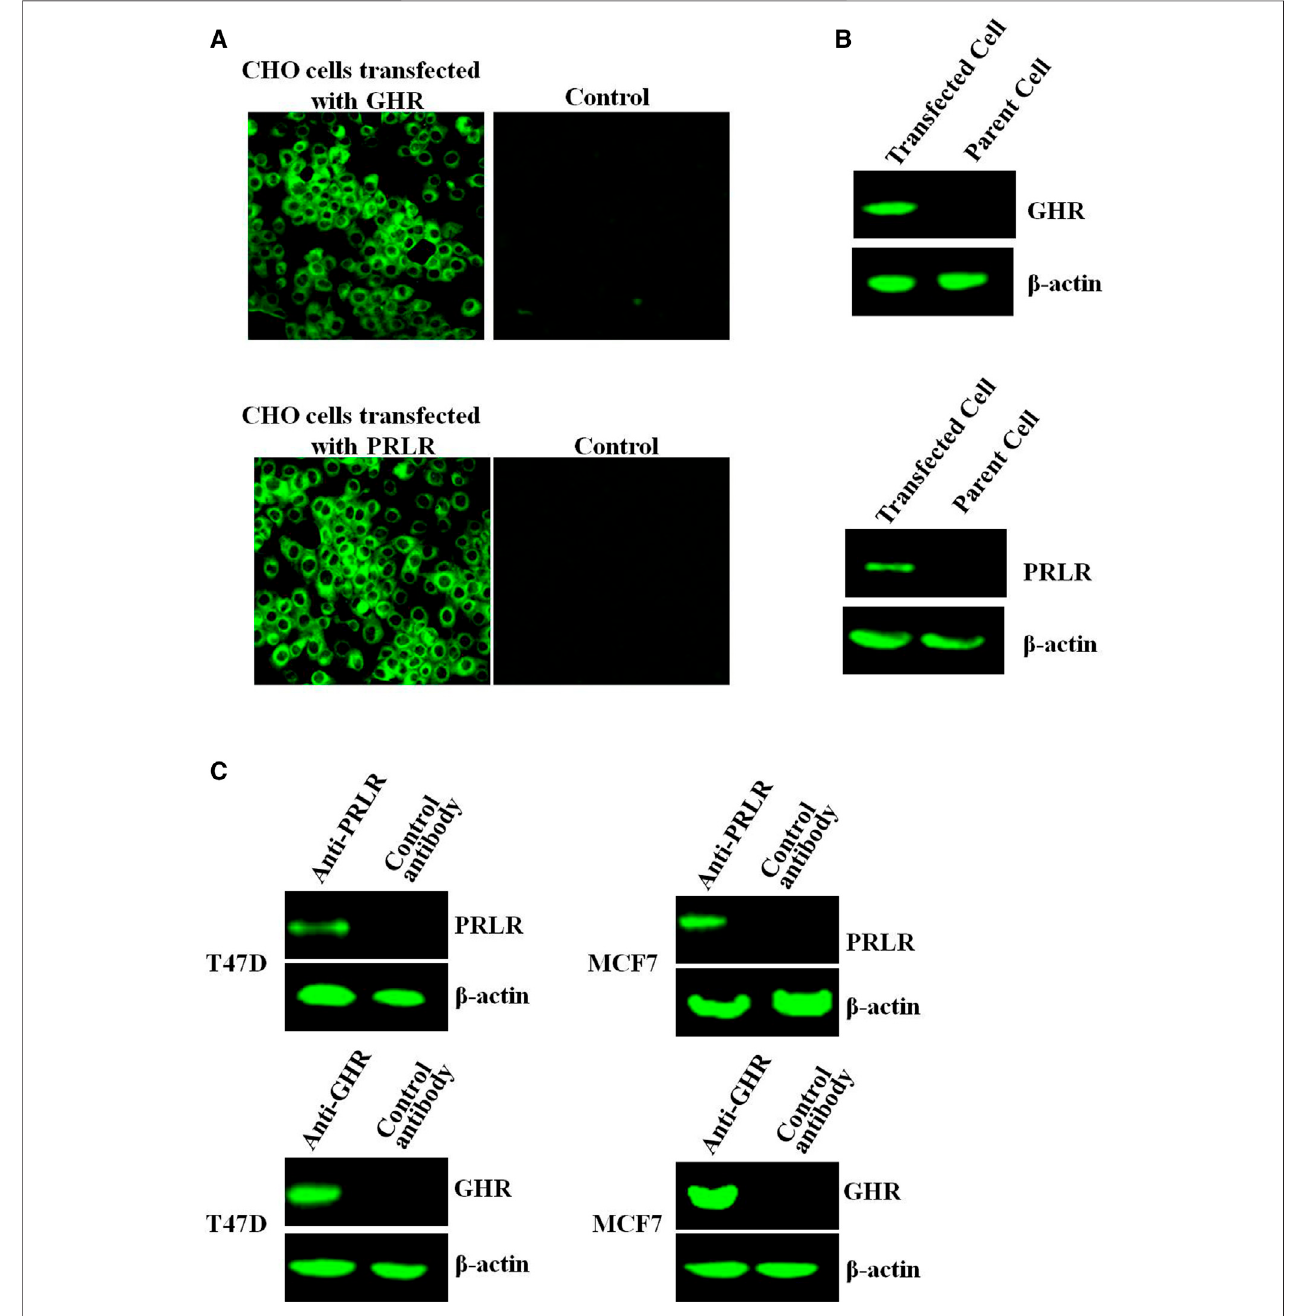
FIGURE 1| (A) The GHR/PRLR expression was analyzed by indirect immuno fl uorescence. The CHO cells transfected with GHR/PRLRwere treated asdescribed as in Materials and methods section (B) The GHR/PRLR expression was assessed by Western-blot. (C) The GHR/PRLRexpression in T47D/MCF7 cells wasevaluated by Western-blot